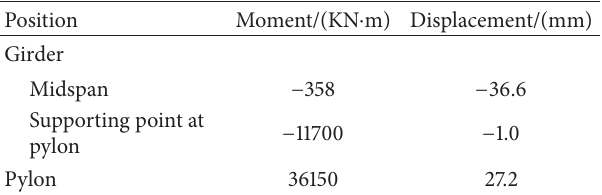
Table 2: Effect of shrinkage and creep of concrete. Position